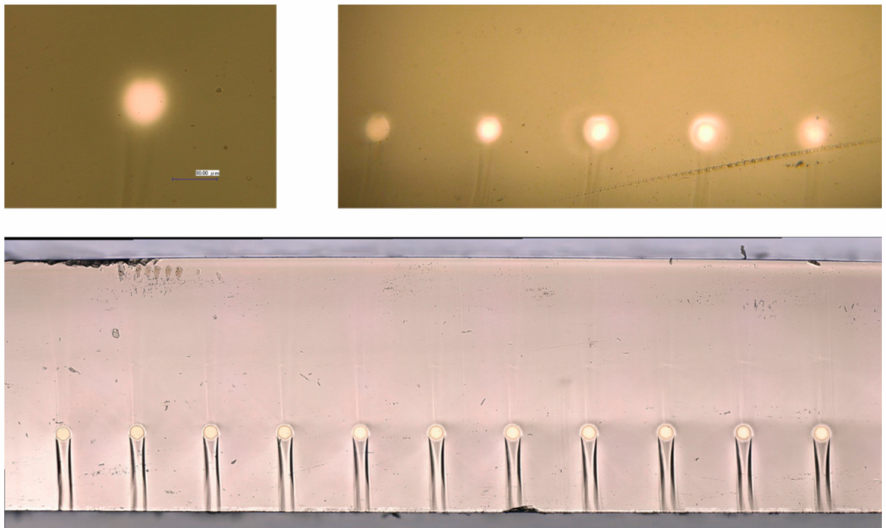
Figure 2. Cross-section of Mosquito GI